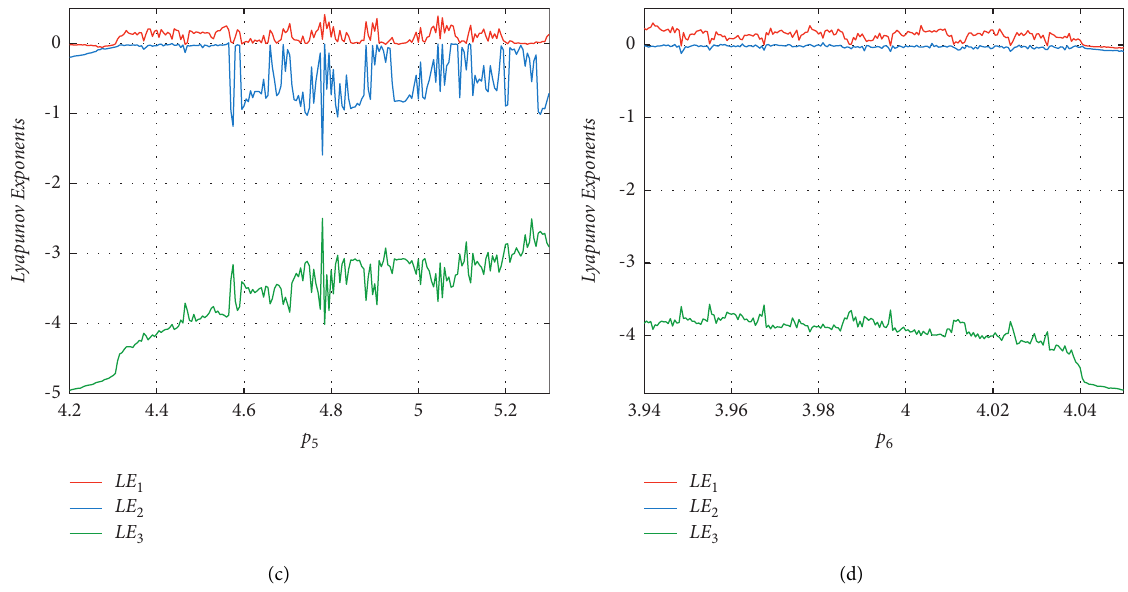
Figure 3: Bifurcation diagrams and LEs spectrum of system (1) with the initial value ( − 1, − 1, − 1) and ( p ,p , p ,p , p , p ,p ) �( 4 , 7 , 7 , 5 , 1 ) . (a) Bifurcation diagram with respect to p 1 2 3 4 5 6 7 � 4 . 5, p ( p ∈ [ 2 . 94 , 4 . 05 ] ). (c) The corresponding LE spectrum with (a). (d) The corresponding LE spectrum with (b). respect to p 6 5 6